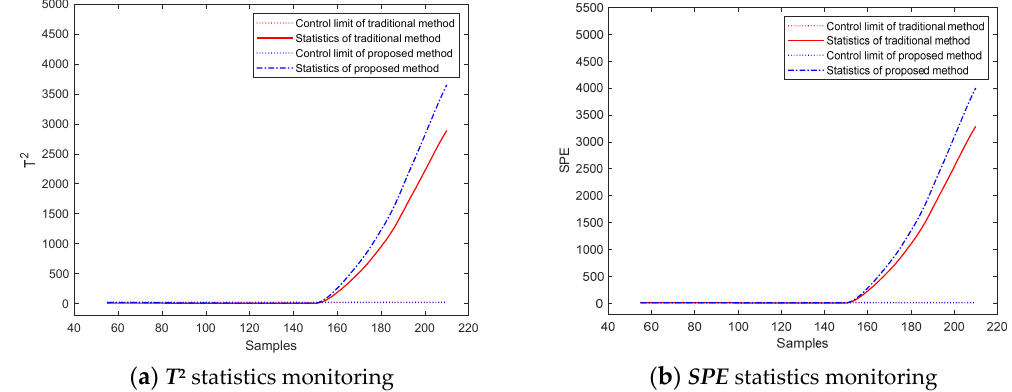
Figure 11. Single-mode online monitoring of sensor fault.